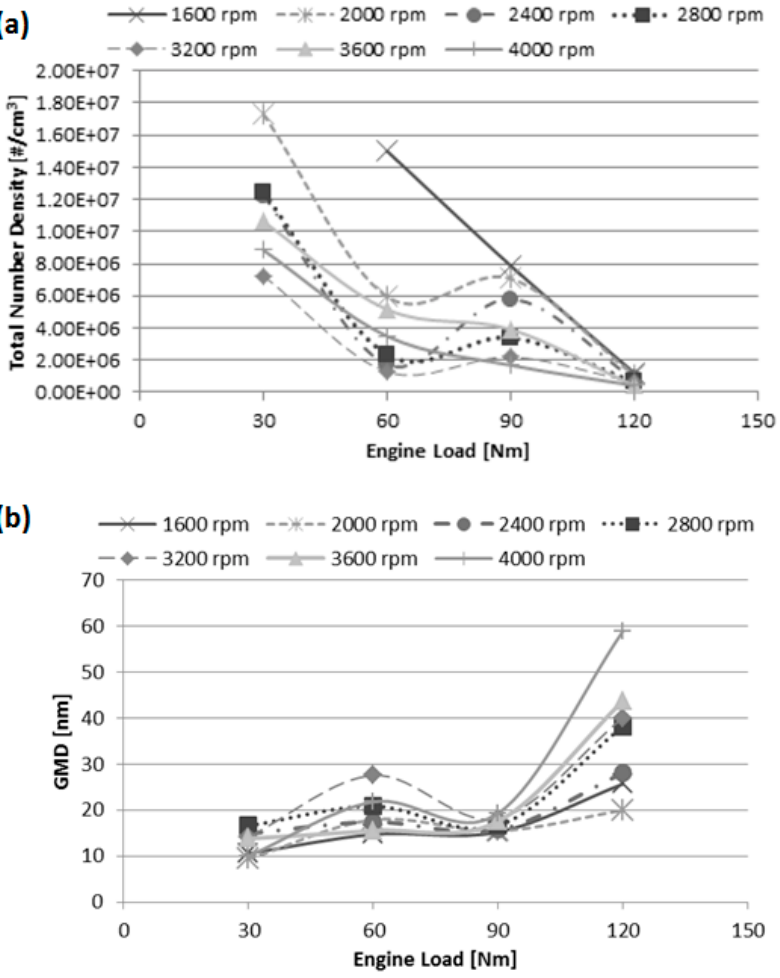
Figure 5. Total particle number density ( a ) and geometrical mean diameter (GMD) ( b ) as functions of engine load, at each of the engine speeds investigated.